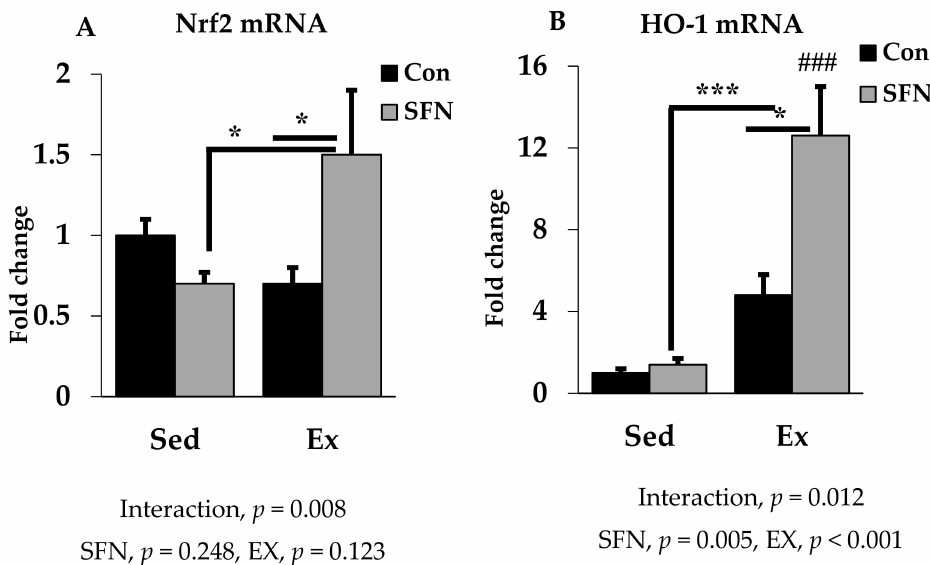
Figure 5. Nuclear factor E2 factor-related factor (Nrf2) mRNA ( A ) and Heme oxygenase 1 (HO-1) mRNA ( B ) expression in the liver in the comparison between the sedentary (Sed) and exercise (Ex) groups, with (sulforaphane; SFN) or without (control; Con) supplement. ### p < 0.001 as compared to the sedentary control. *** p < 0.001, * p < 0.05. Interaction of SFN and Ex written as “Interaction”. Data are presented as mean ±